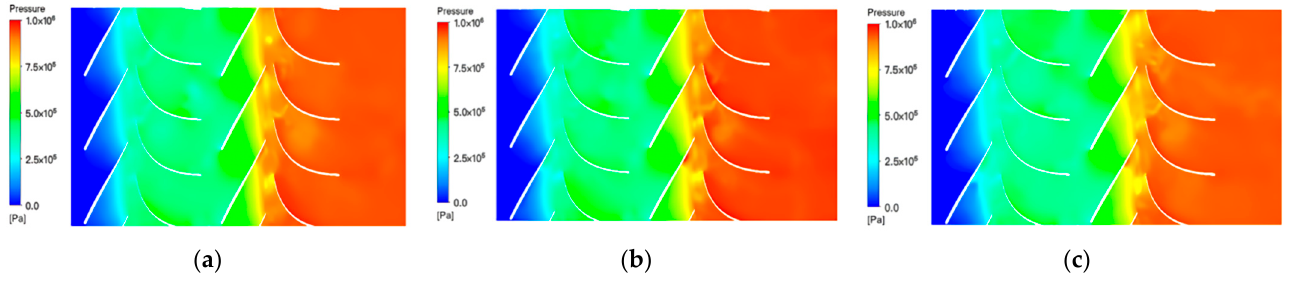
Figure 7. Pressure distribution on first-stage impeller-guide vane B2B view: ( a ) C v = 4%; ( b ) C v = 7.5%; ( c ) C v = 11.5%.